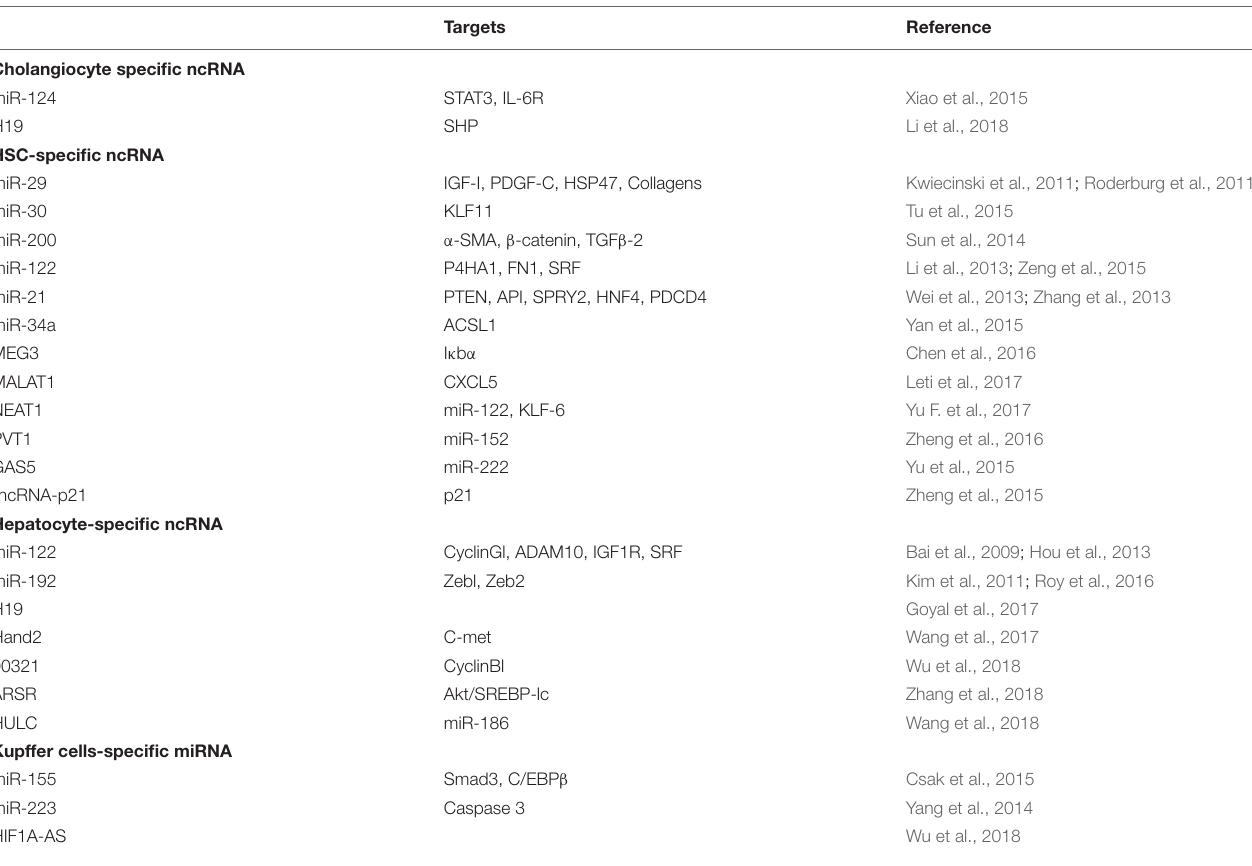
TABLE 1 | ncRNA altered in liver